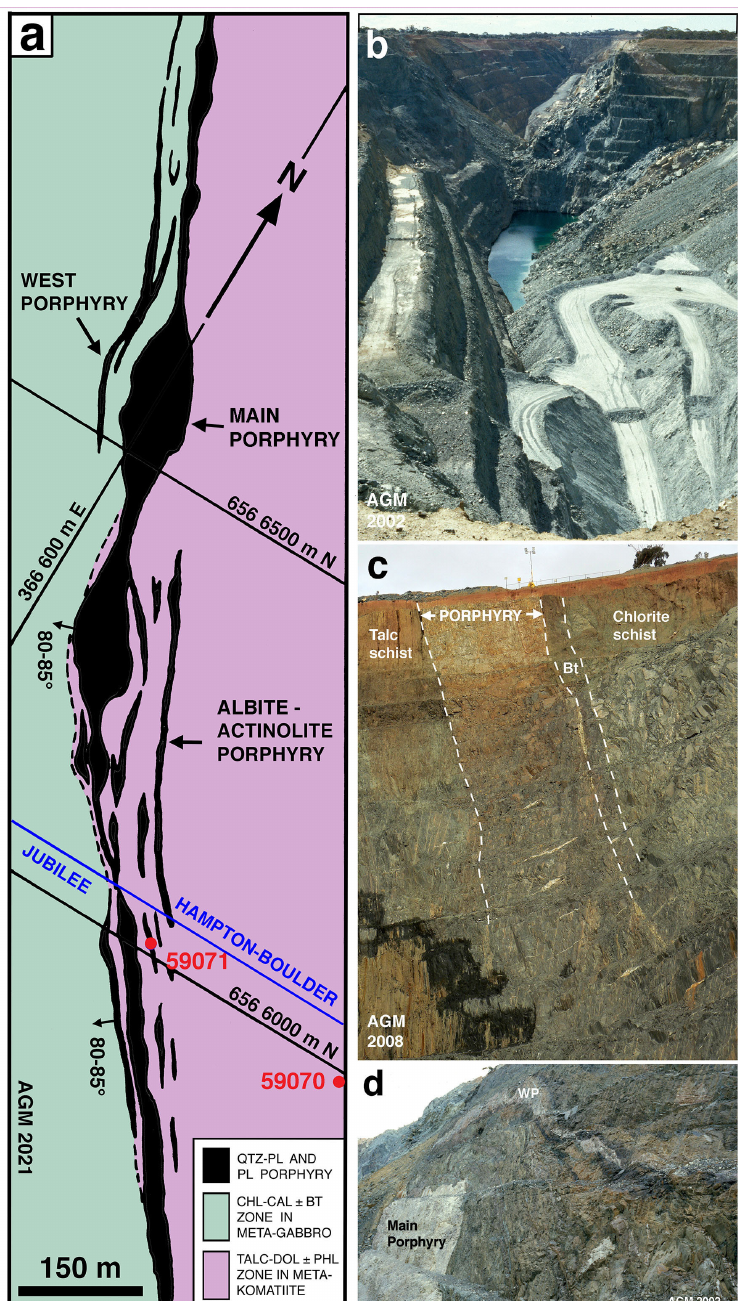
Figure 2. Porphyry dykes in the New Celebration gold deposit. ( a ) Map at 300 m above sea level showing the quartz-plagioclase (qtz-pl) and plagioclase porphyries at the contact of chlorite-calcite-biotite (chl-cal-bt) and talc-dolomite-phlogopite (talc-dol-phl) schist (modified from [14]). Surface samples 59070 and 59071 are projected. UTM coordinates are MGA 1994. ( b ) Looking N 35 ◦ W across the open pit in 2002. At the bench above the water table, the strike of the Boulder Lefroy Fault changes from N 40 ◦ W to N 15–20 ◦ W. ( c ) Looking SW at the wall of the Jubilee pit in 2008: the Main Porphyry separates chlorite-calcite schist and a biotite contact zone (Bt) from talc-dolomite schist. Flat quartz veins (white) link movement planes. ( d ) Looking south at the West Porphyry (WP) and brown biotite contact alteration (3–5 g/t Au) in chlorite-calcite schist, Hampton Boulder pit in 2002. The bench height is 10 m.